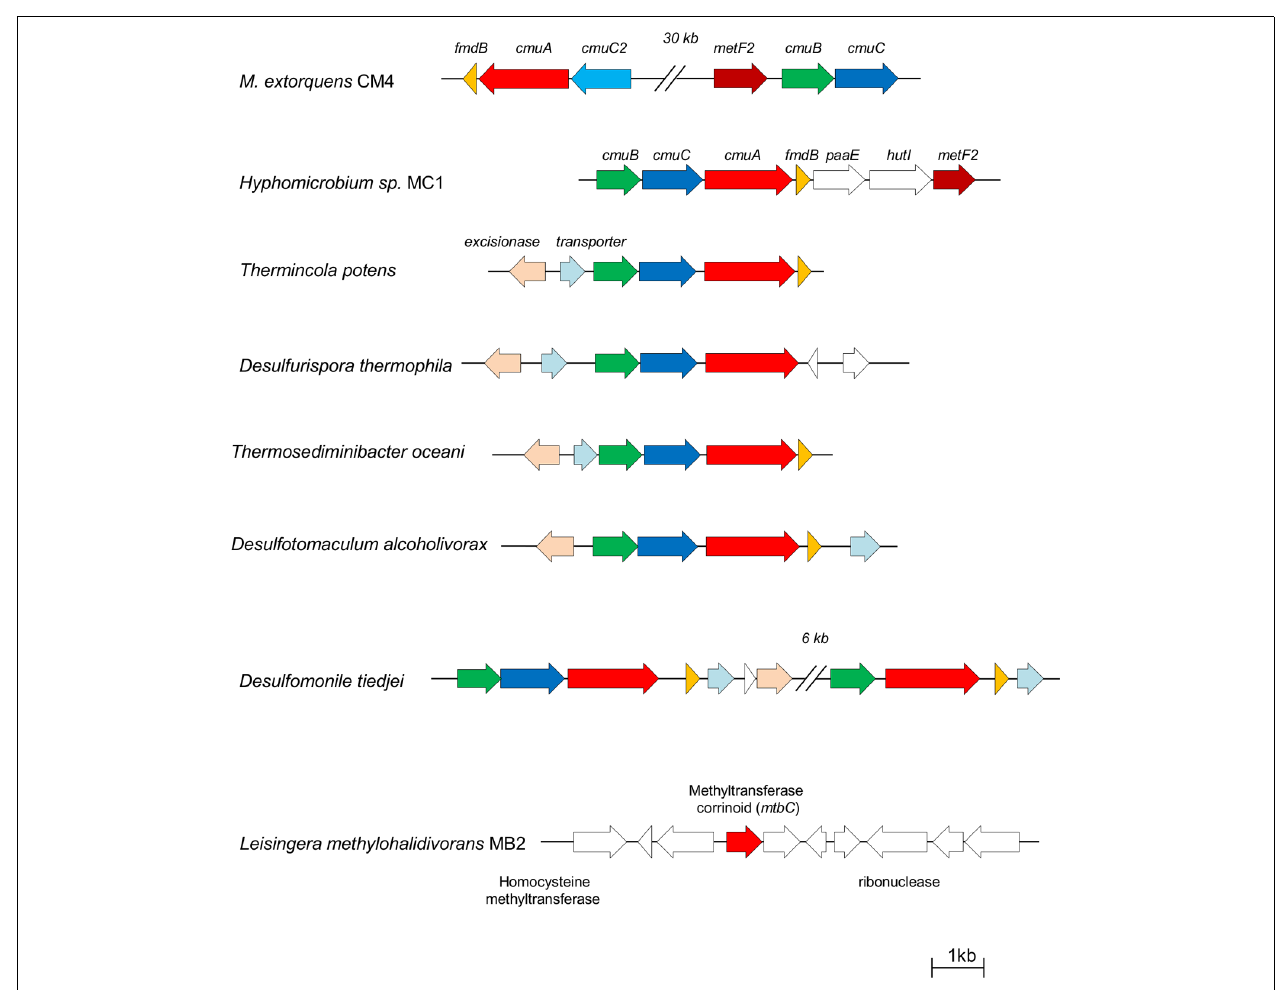
FIGURE 1 | Comparison of cmu gene organization in sequenced genomes of chloromethane-degrading bacteria. Arrows represent protein-coding genes, and homologous genes are shown in the same color. Gene clusters are drawn to